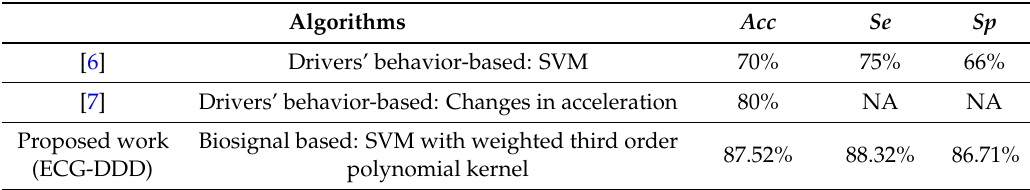
Table 3. Comparison of